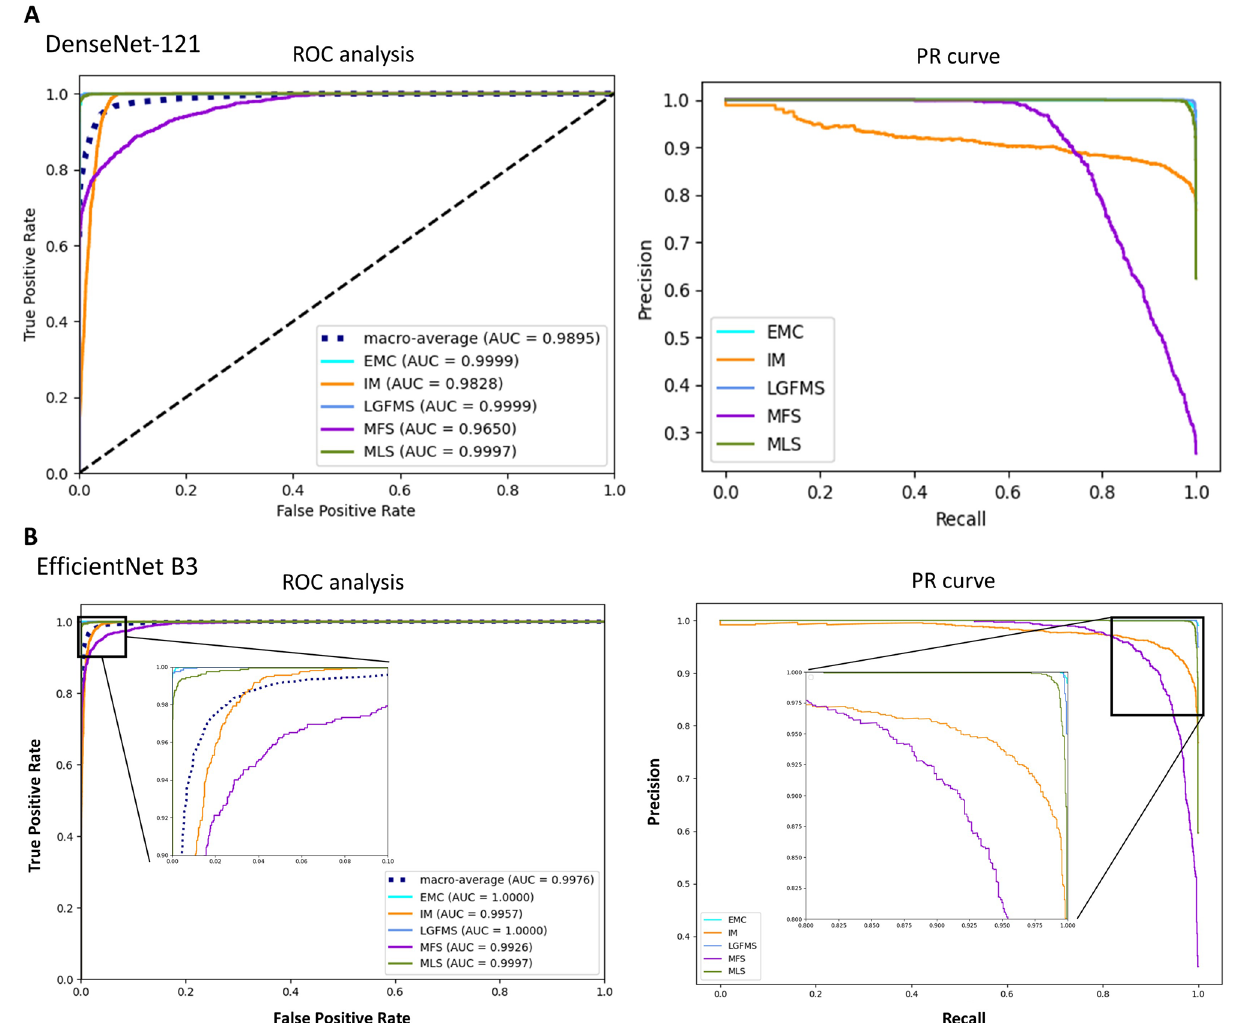
Figure 4. Receiver operating characteristic 25 curve and Precision-Recall 28 curve of DenseNet-121 ( A ) and EfficientNet B3 ( B ). EMC extraskeletal myxoid chondrosarcoma, IM intramuscular myxoma, LGFMS low grade fibromyxoid sarcoma, MFS myxofibrosarcoma, MLS myxoid